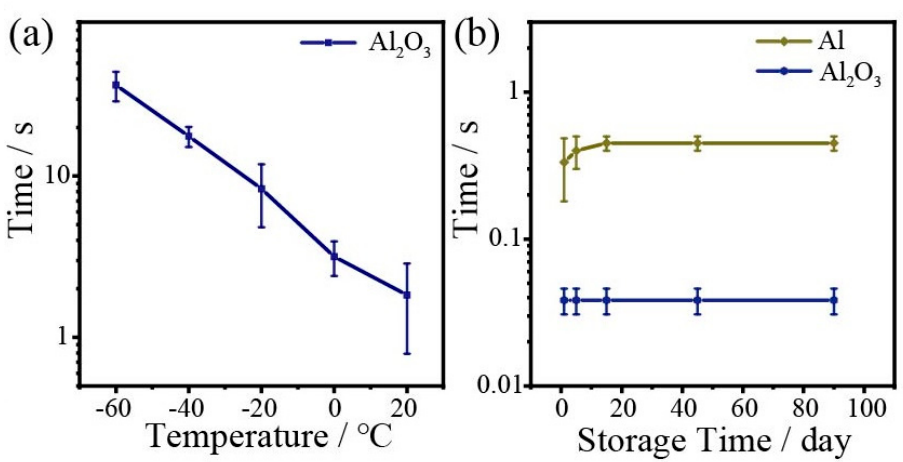
Figure 7. ( a ) Irradiation time in low-temperature environments with a laser power of 21.5 mW at 976 nm. ( b ) The stability of irradiation time for Al NIs and the Al/Al 2 O 3 (50 nm)